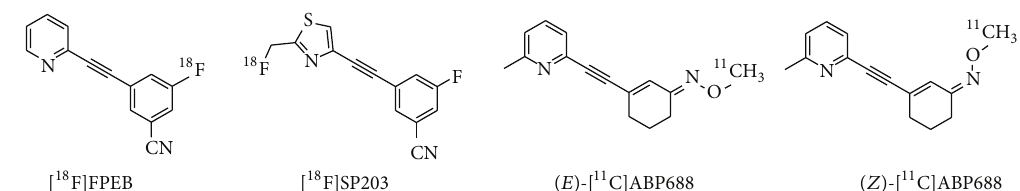
Figure 10: Chemical structure of imaging probes for mGluR5.